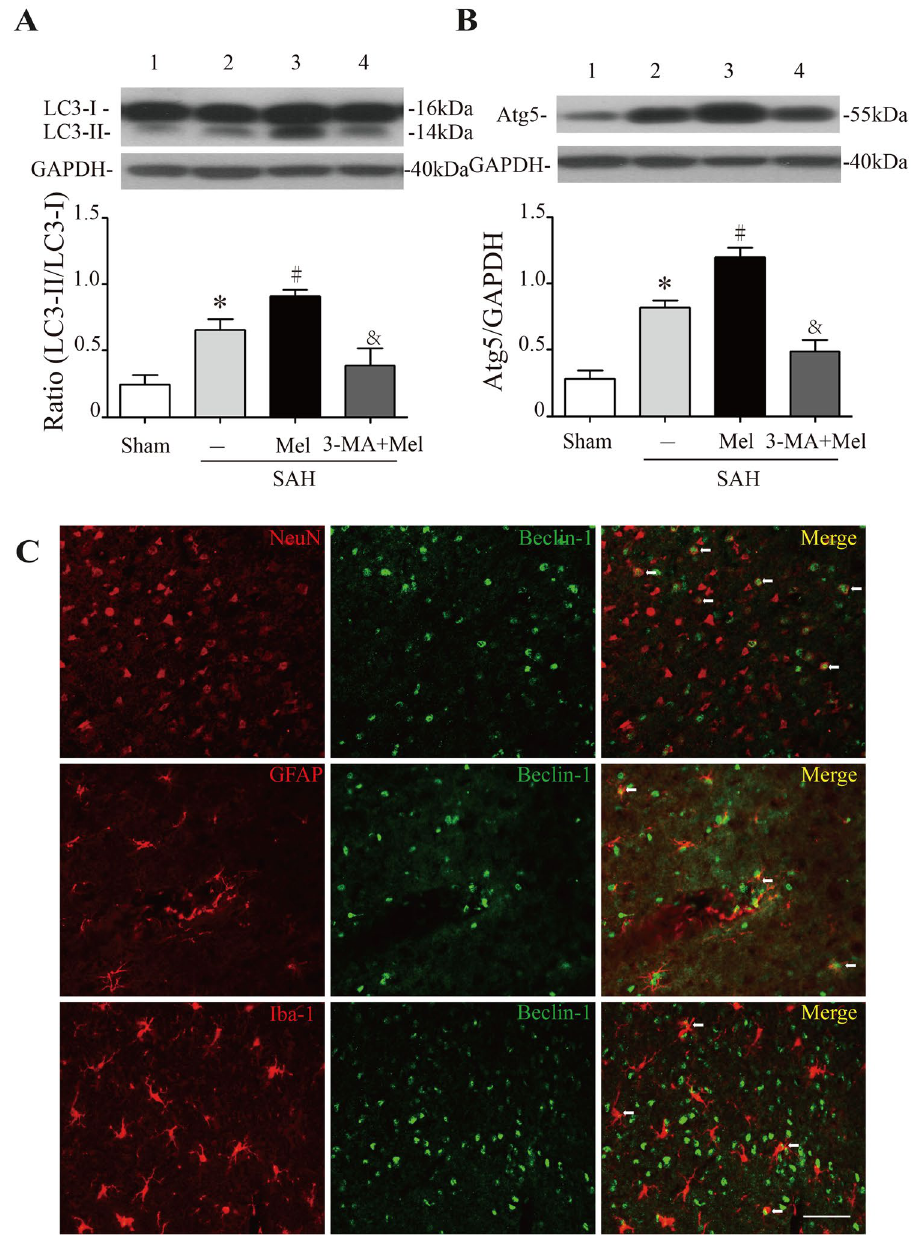
Figure 2. Effect of melatonin treatment on autophagy. ( A ) The Western blot relative band density of LC3; n = 6 per group. ( B ) The Western blot relative band density of Atg5; n = 6 per group. The cropped bands had been run under the same experimental conditions. ( C ) Representative micrographs showing double immunofluorescence labeling of Beclin-1 with NeuN (neuronal marker), GFAP (astrocyte marker) and Iba-1 (microglia marker) in the ipsilateral basal cortex at 24 h after SAH. White arrows indicated double-labeled cells. Scale bar = 50 μ m. * P < 0.05 versus sham group, # P < 0.05 versus SAH + vehicle group, and & P < 0.05 versus SAH + Mel